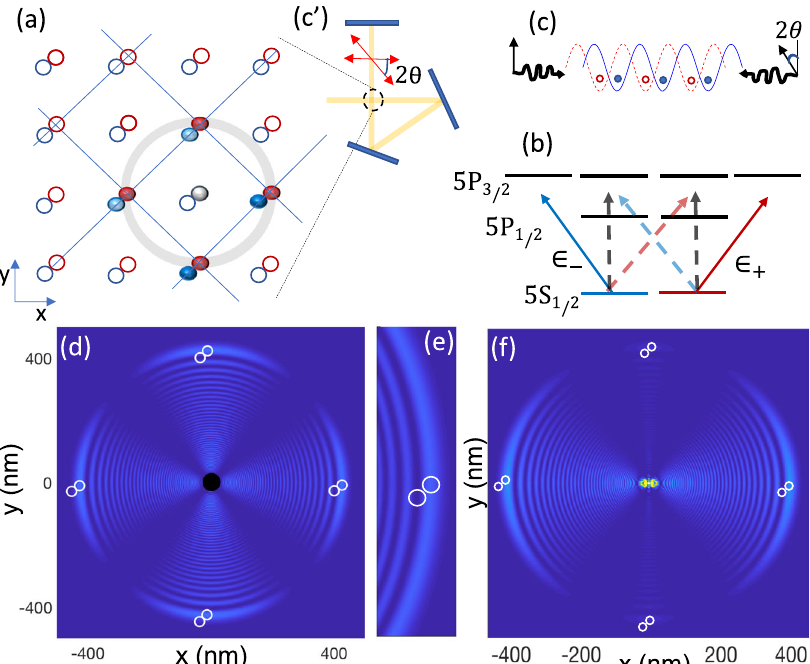
Fig. 1 Rydberg-Fermi interaction in Spin-dependent lattice. a In a 2D structure with a single atom per site, applying a qubit-dependent lattice-shift makes each atom in a spatial superposition of being in red and blue sites where the components are controlled by the internal electronic qubit-states 0 j i and 1 j i . Hence the Rydberg electron of the central atom would exclusively scatter from the plaquette atoms in a speci fi c spin-lattice, providing qubit-dependent interaction. b In 87 Rb, tuning the trapping laser between 5 P 3/2 and 5 P 1/2 , the polarizability of qubit states 0 j i and 1 j i are given by distinguished left ε − and right ε + circularly polarized lights respectively. c , c' Counter propagating linearly polarized lights with relative polarization of 2 θ , form two distinguished optical-lattices of ε − and ε + displaced by D { x , y } = 2 θ / k in each dimension, trapping different qubit states. d Exciting the Rydberg superposition state of Eq. (4) with n = 64 with the quantization axis being perpendicular to the lattice plane provides a symmetric interaction over the four neighboring plaquette atoms. e The zoomed vision shows that the 0 j i and 1 j i qubit states of the plaquette atoms are localized on the (cid:1) node and anti-node of the Rydberg wave-function, providing a qubit-dependent contrast of Fermi scattering. f Two-color excitation of ðj 65 P ffiffiffi p (cid:1) (cid:1) Þ = 65 P 1 = 2 ; 1 = 2 2 with in-plane quantization axis provides couplings with two opposite plaquette atoms in the